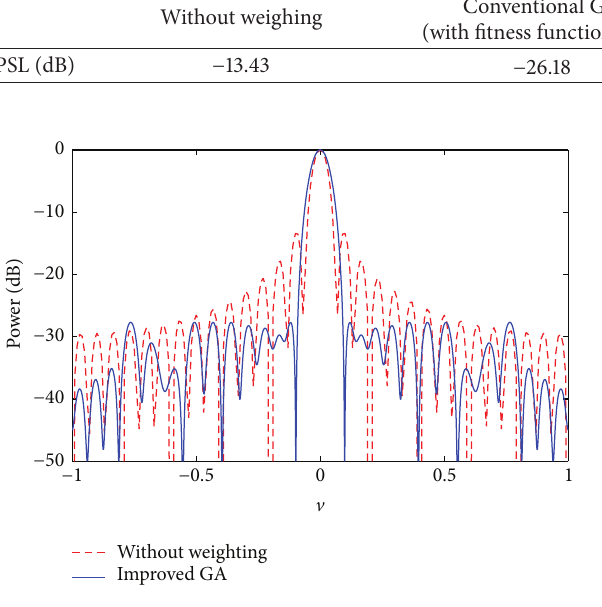
Figure 8: Sum patterns: improved GA.